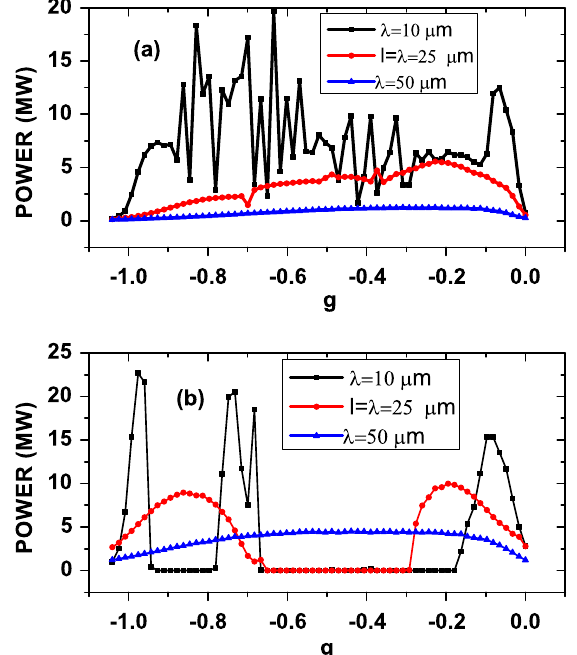
FIG. 5. Variation of outcoupled power as a function of the stability parameter ( g ), for different wavelengths, with a hole size of (a) 1 mm and (b) 4